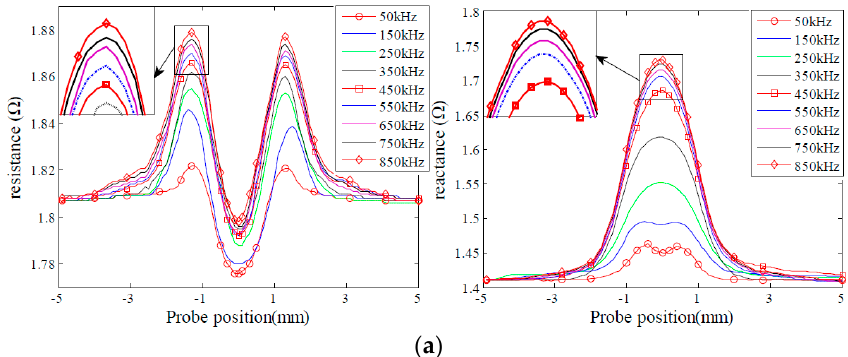
Figure 4. Cont. Figure 4. Cont.